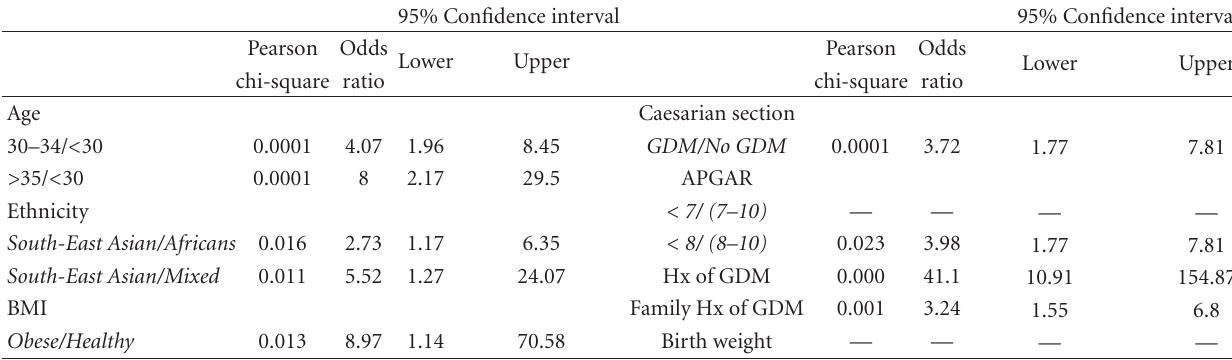
Table 2: Odds-ratios and Pearson chi-square tests.